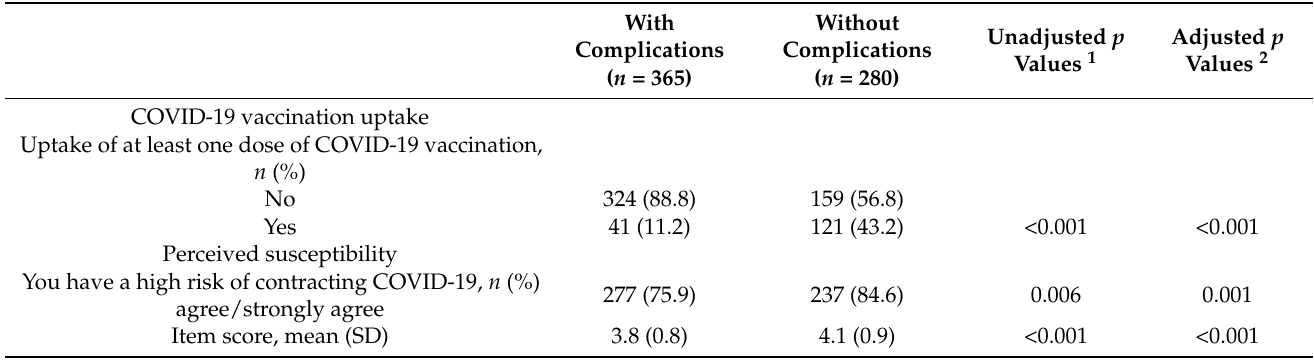
Table 2. Comparing COVID-19 vaccination uptake and perceptions related to COVID-19 vaccination between diabetes mellitus (DM) patients with and without